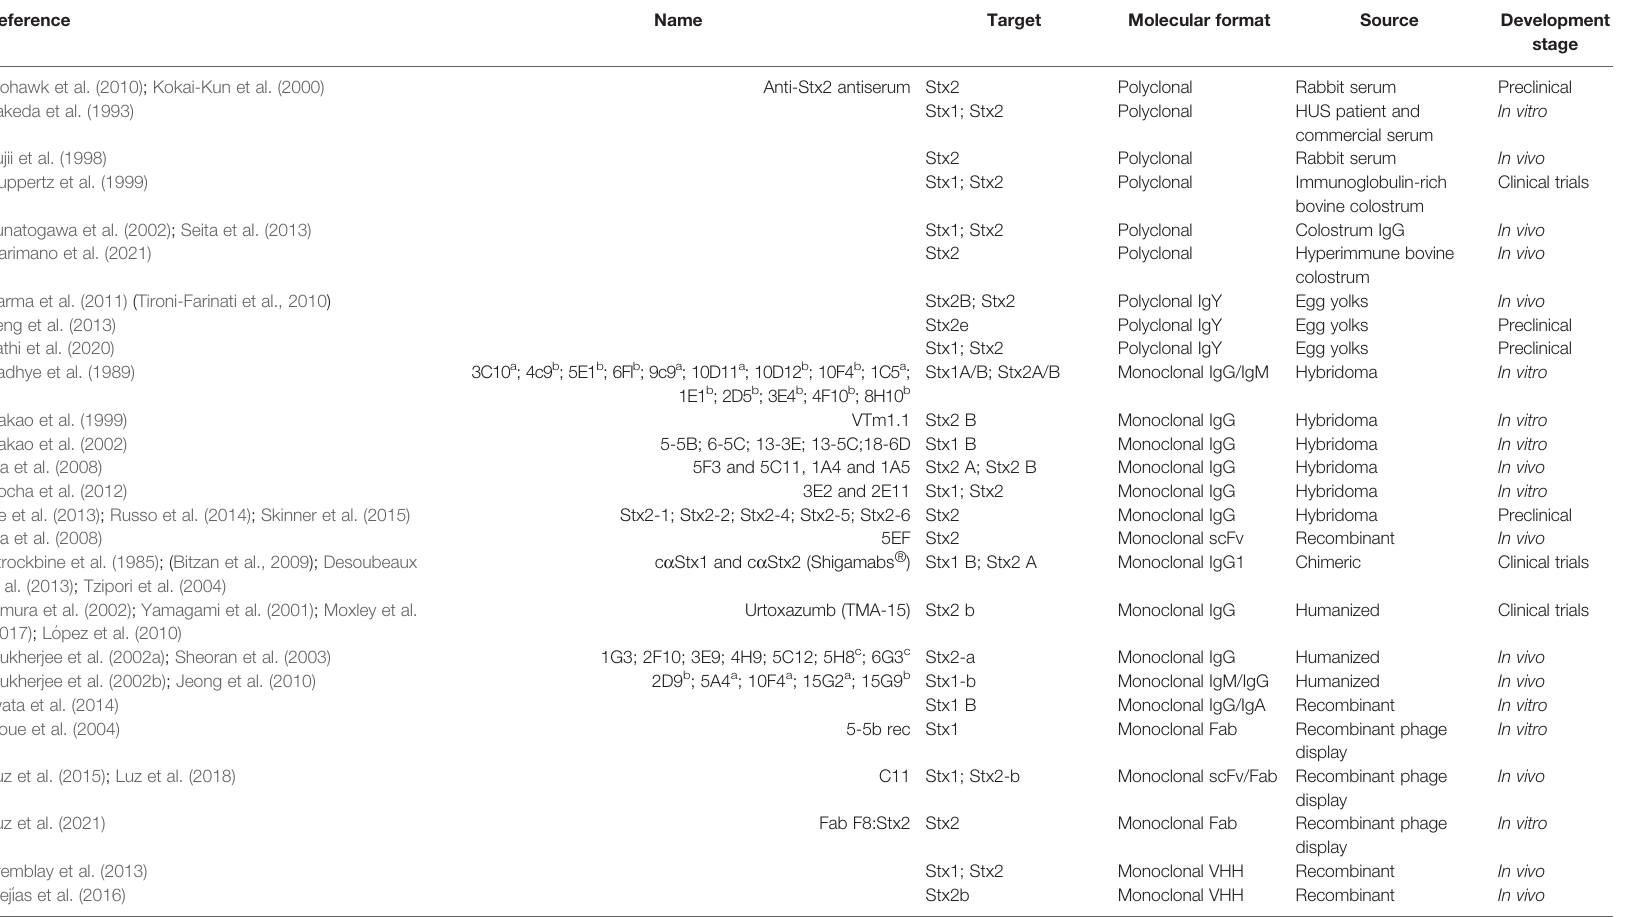
TABLE 1 | List of antibodies included on this paper and their development